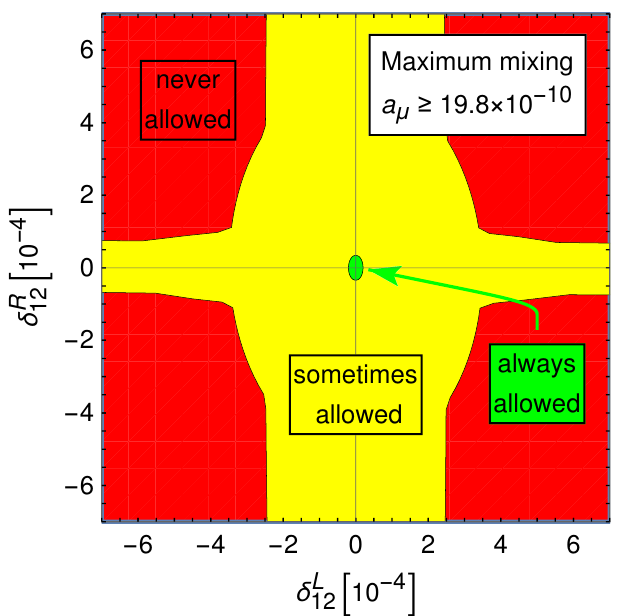
Figure 13. Scan over parameter choices for which a (cid:22) agrees with the deviation (3.3), displaying regions for (cid:14) L and (cid:14) R allowed by the MEG limit on (cid:22) e(cid:13) (3.7). The small, inner green region is 12 12 ! allowed by all parameter choices which explain a (cid:22) , the cross-shaped large yellow region is allowed by some parameter choices, and the outer red region is not allowed by any parameter choice.